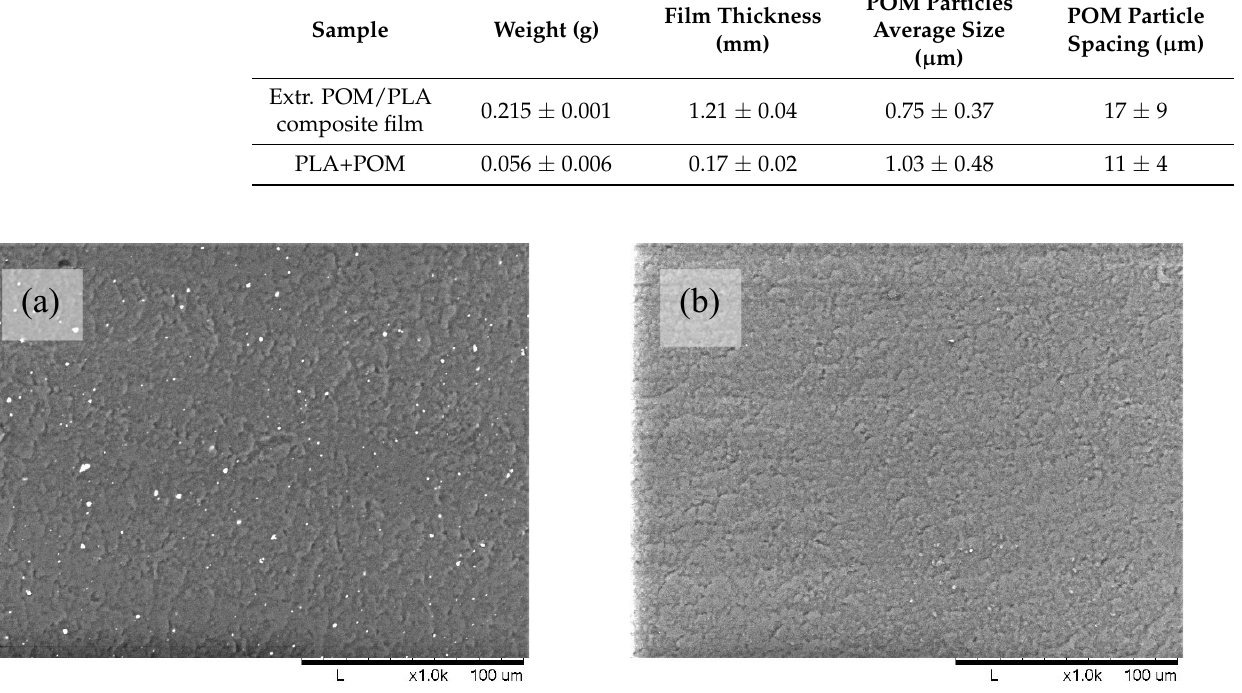
Figure 5. SEM images of extruded films: ( a ) Extr. POM/PLA film; ( b ) blank Extr. PLA film at ×1000 magnification.